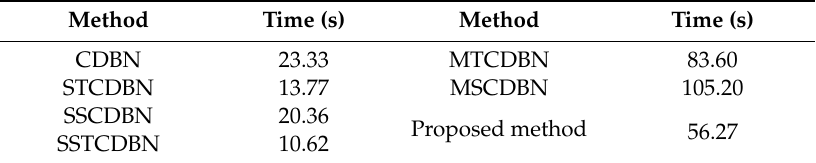
Figure 4. Detection performance of different convolutional deep belief network (CDBN) structures. Table 6. Runtime of di ff erent CDBN